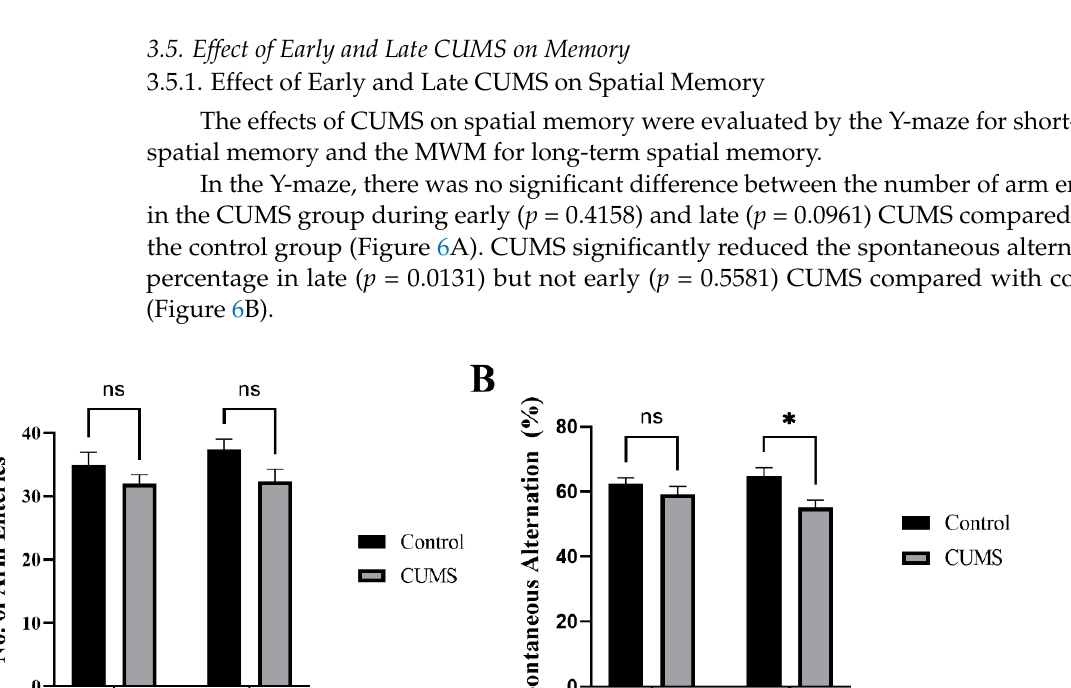
Figure 5. The effect of early and late CUMS on depression tests in the ( A ) TST, ( B ) FST, and ( C ) SPT. Two-way ANOVA was used, followed by Šídák’s multiple-comparisons test. (*) indicates a signifi- cant difference between the CUMS groups and the control group at p > 0.05, ** p < 0.01. ns: not significant.